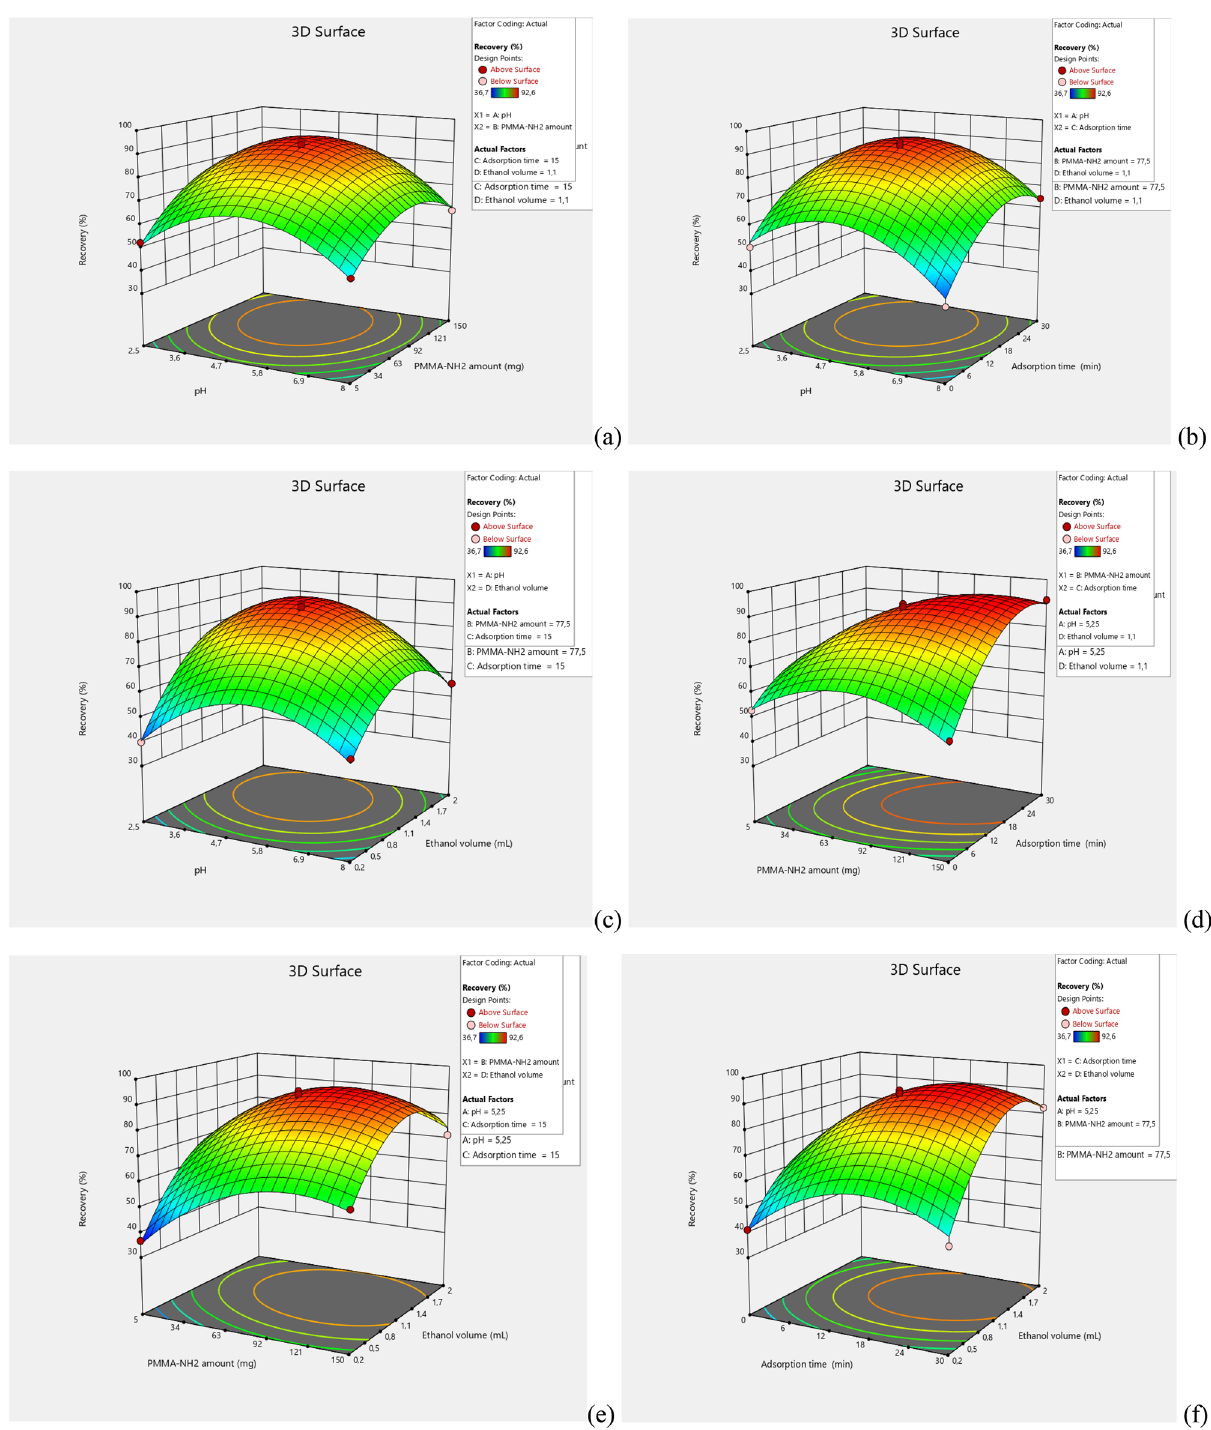
ethanol volume (mL)- PMaema amount (mg); ( f ) adsorption time (min)-